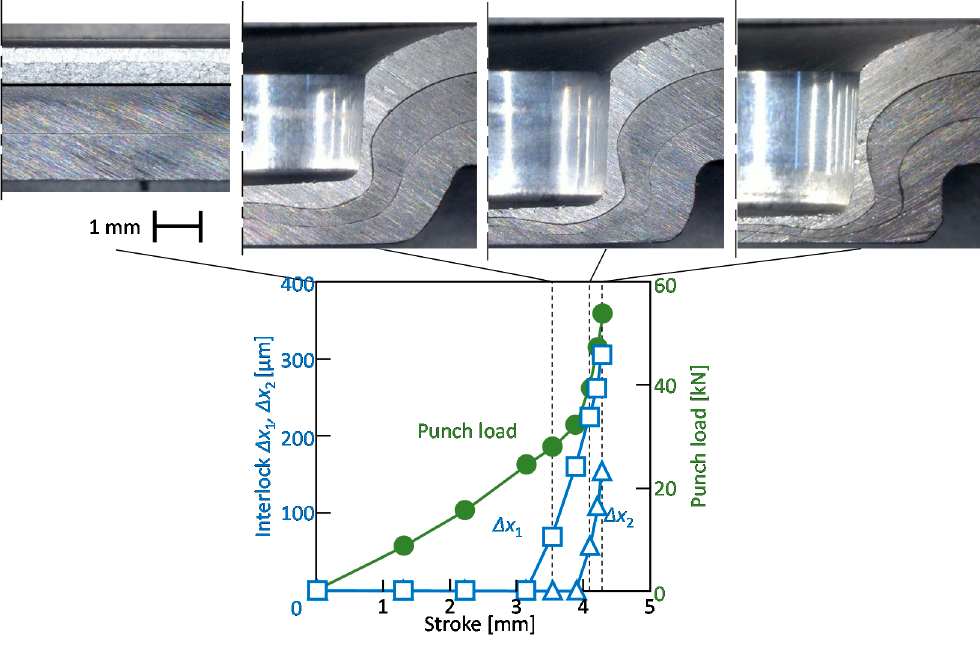
Figure 18. Deforming behaviors of sheets and punch load-stroke curves for d = 9.0 mm, h = 1.7 mm, without adhesive and 270 MPa steel sheets obtained from the experiment.